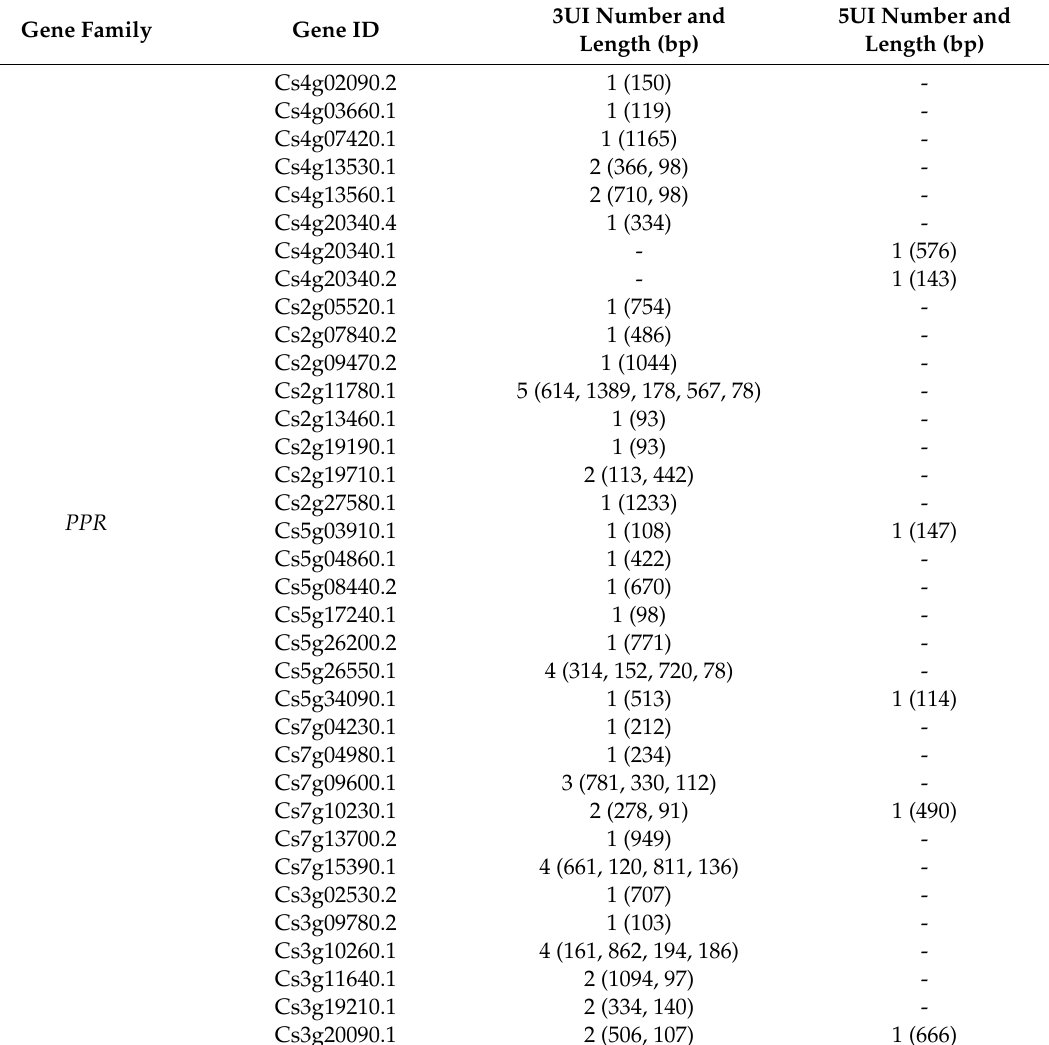
Table 4. 5 (cid:48) UTR intron (5UI) and 3 (cid:48) UTR intron (3UI) numbers and length in UTRs of UI-containing pentatricopeptide repeat containing proteins ( PPRPs ) and disease resistance ( R ) genes. Gene